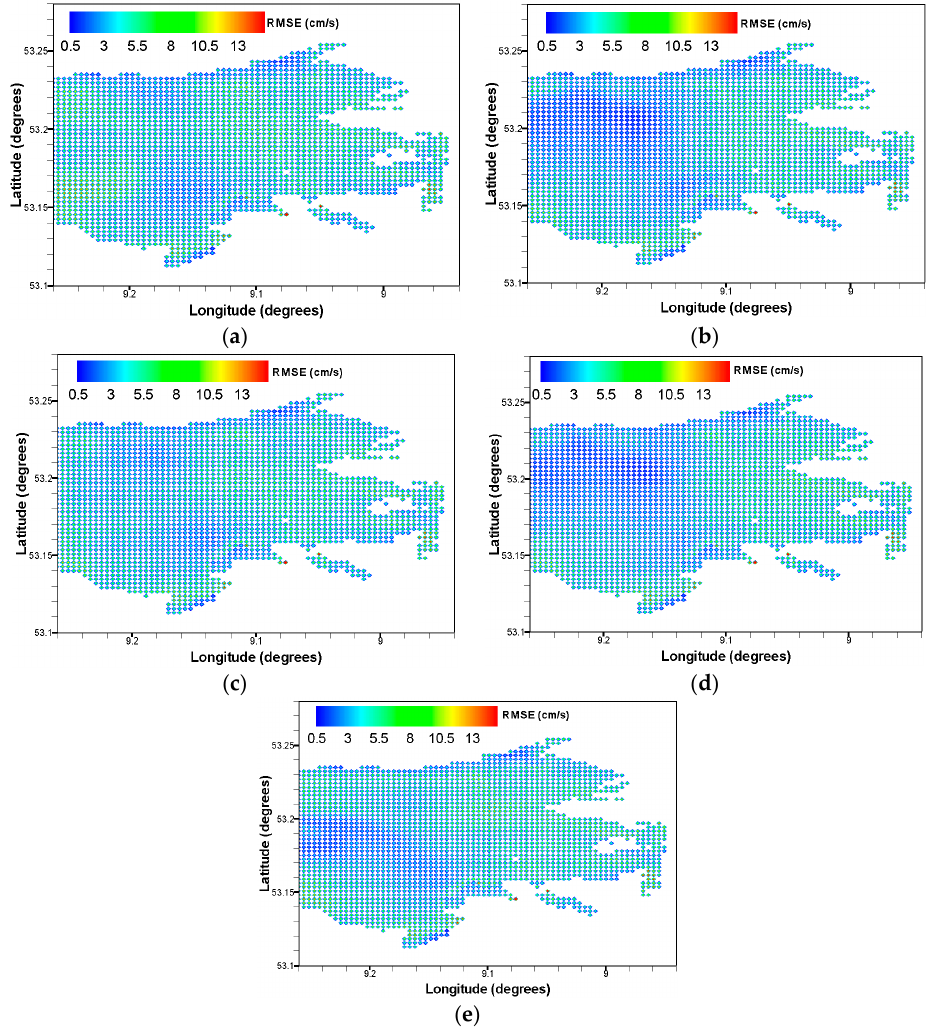
Figure 9. Spatial distributions of RMSE values during the ≥ 6 h forecasting period: ( a ) Model FR; ( b ) model DI; ( c ) model OI; ( d ) model NDA; and ( e ) model IDA.